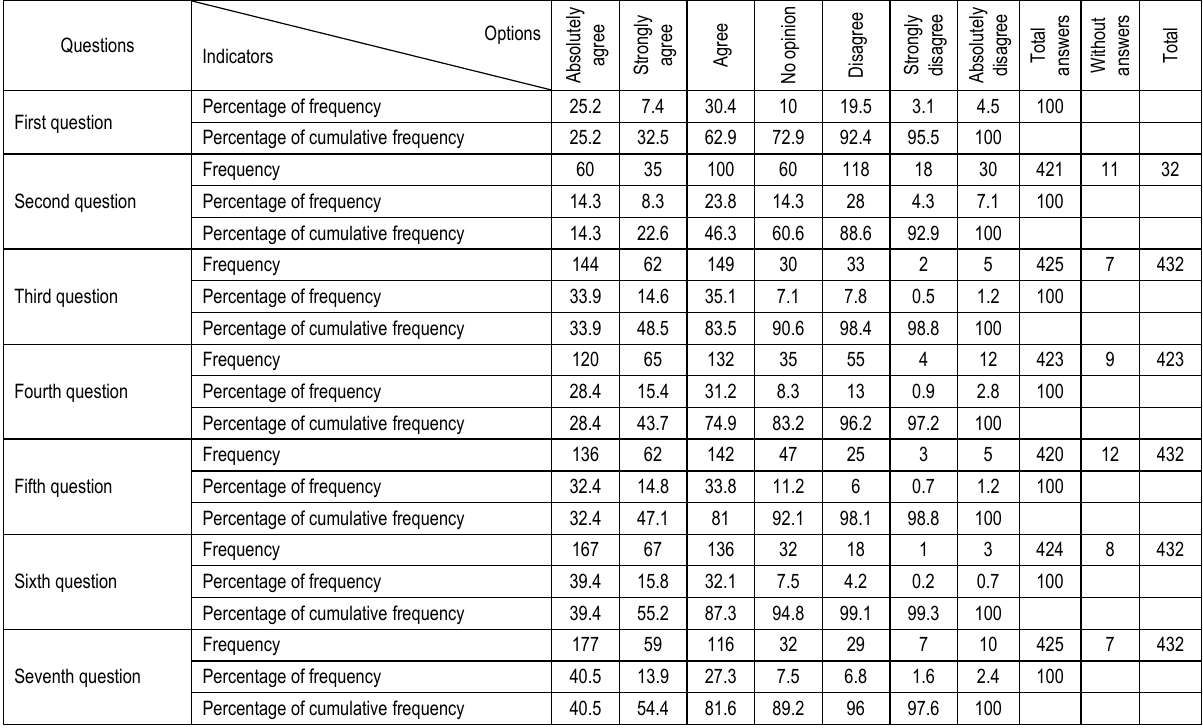
Table 4 (cont.). Response data description of principals’ to the questions of program and supplementary